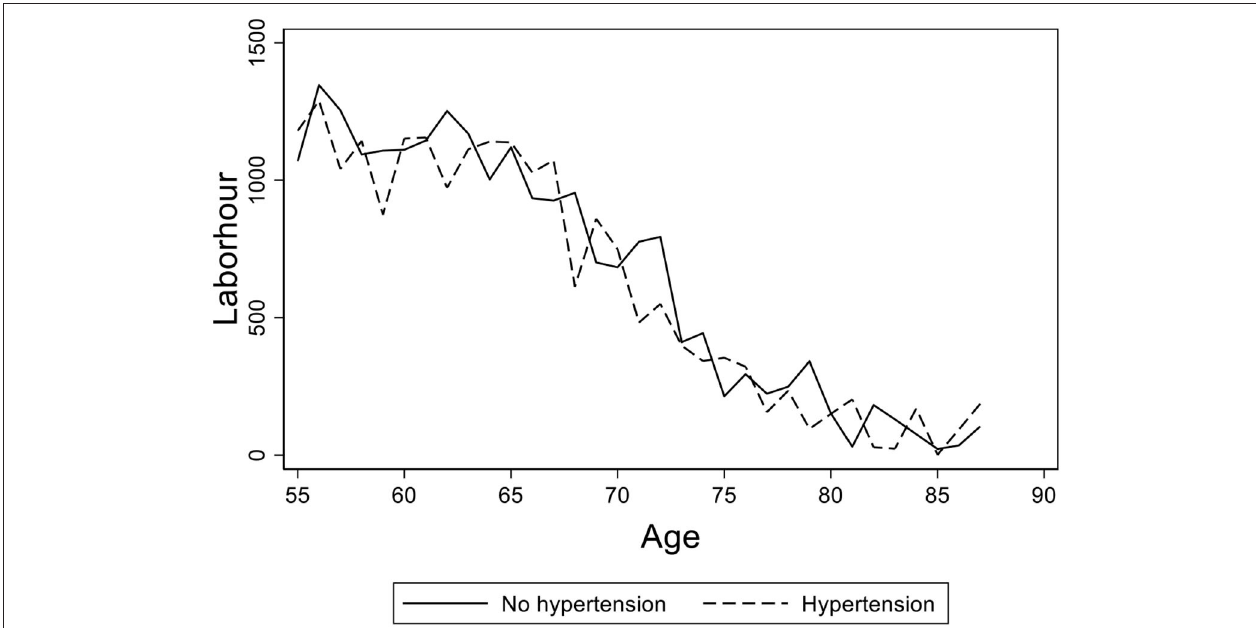
FIGURE 2 | The age distribution of average working hours for the elderly with hypertension diagnosed or not. Data from the China Health and Nutrition Survey (CHNS) database. The figure shows the age distribution of average working hours for the elderly with hypertension diagnosed or not in rural China. The solid line shows the age path of the elderly without hypertension and the dashed line shows the ones with hypertension diagnosed.